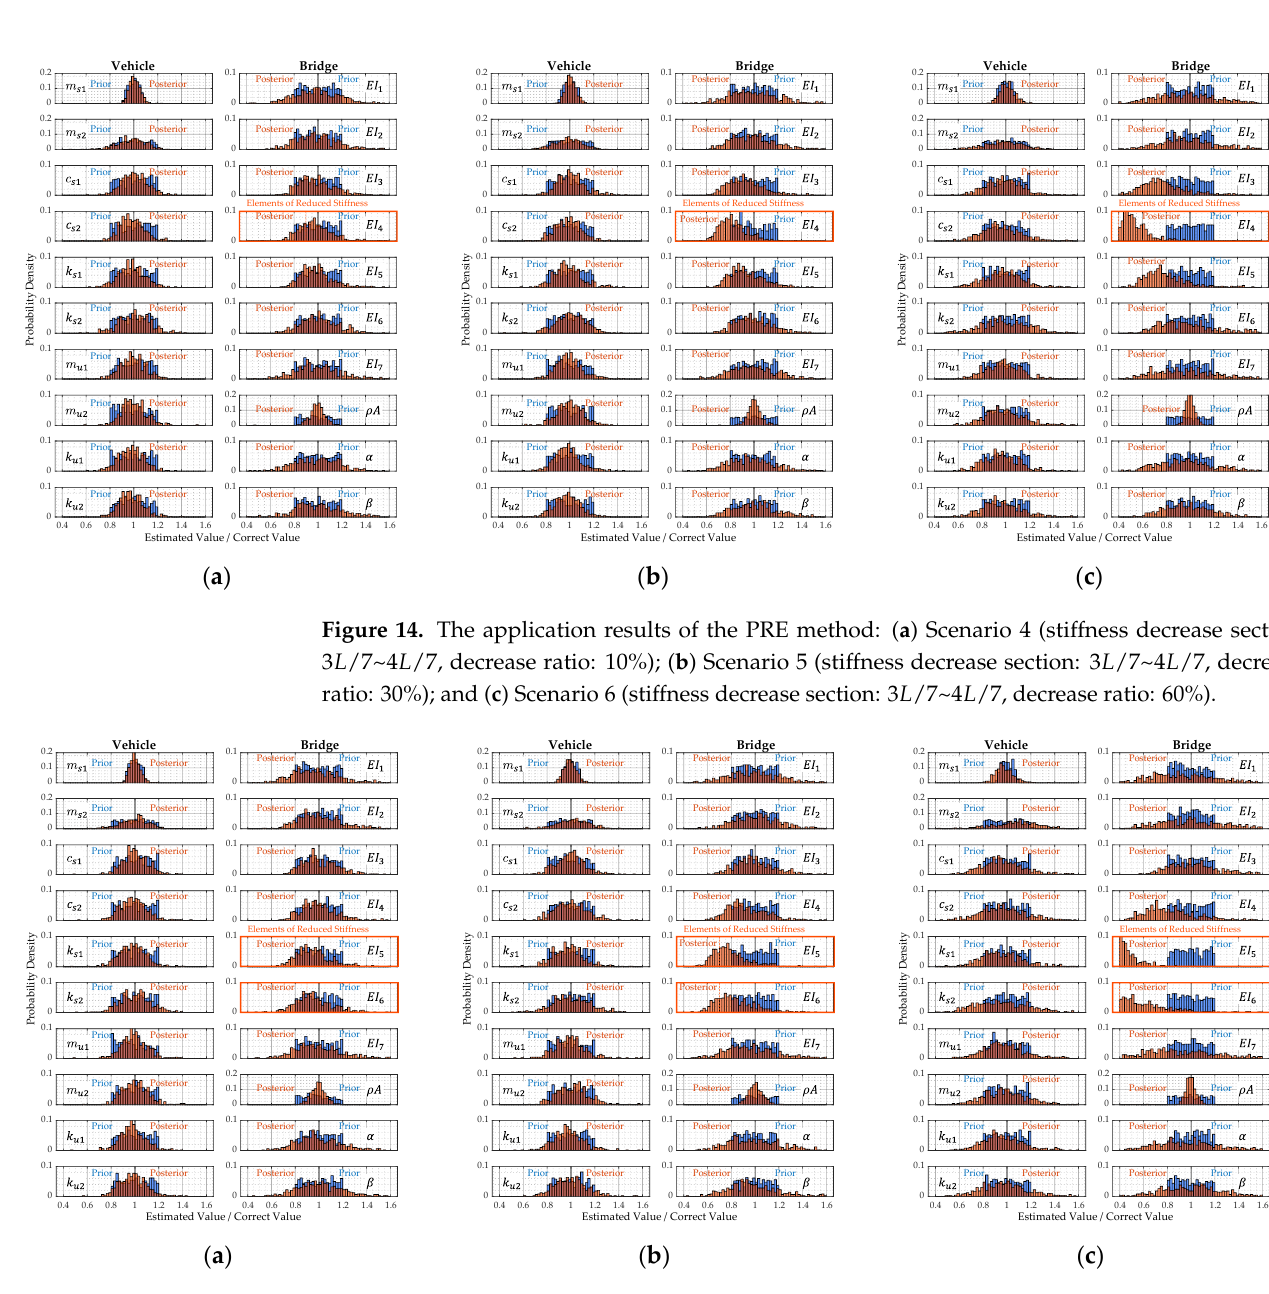
Figure 15. The application results of the PRE method: ( a ) Scenario 7 (stiffness decrease section: 4𝐿/7 ~ 6𝐿/7 , decrease ratio: 10%); ( b ) Scenario 8 (stiffness decrease section: 4𝐿/7 ~ 6𝐿/7 , decrease ra- tio: 30%); and ( c ) Scenario 9 (stiffness decrease: 4𝐿/7 ~ 6𝐿/7 , decrease ratio: 60%);.